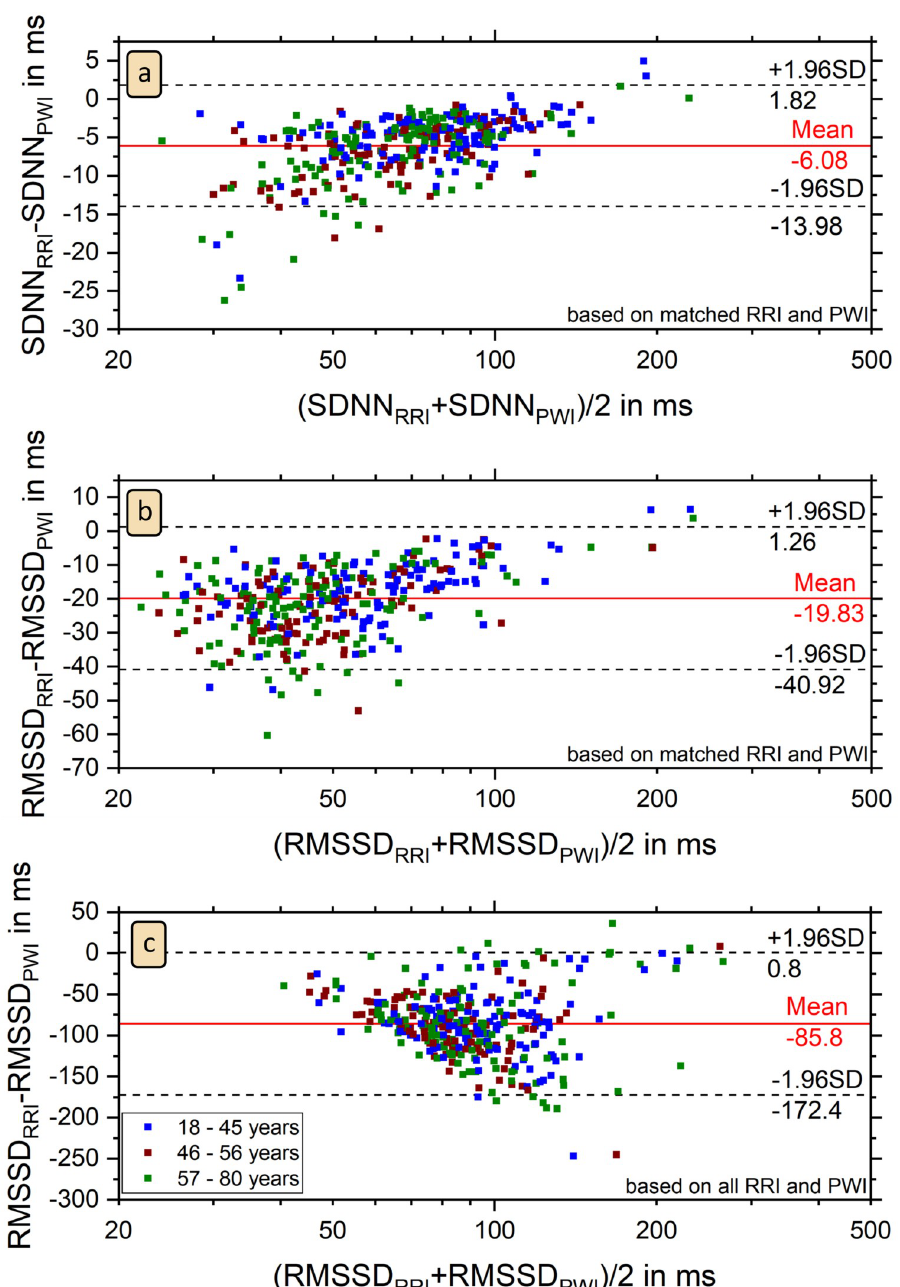
Fig 8. Bland-Altman plots of SDNN and RMSSD. The plots show that SDNN and RMSSD values derived from PWI are larger than those derived in the standard way from RRI for nearly all 351 subjects. There are only six outliers for (a) SDNN comparing associated RRI and PWI, three for (b) RMSSD comparing associated RRI and PWI, and eight for (c) RMSSD comparing all RRI and all PWI. In panel (c), one extreme outlier for a subject with 16 percent of ectopic beats and RMSSD all RRI = 377 ms, RMSSD all PWI = 163 ms does not appear in the plot. No clear differences between the three age groups (see Table 3) can be seen.